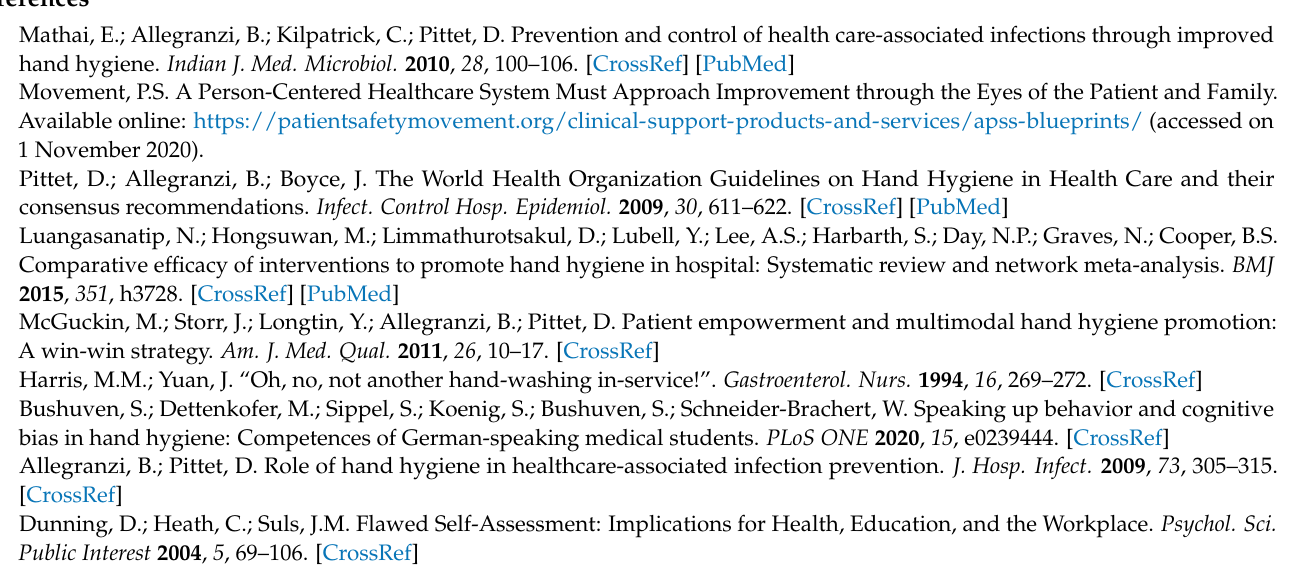
B. Table S1: Demographic items in the questionnaire in German and English language; Table S2: For the present study relevant Items in the questionnaire in German and English